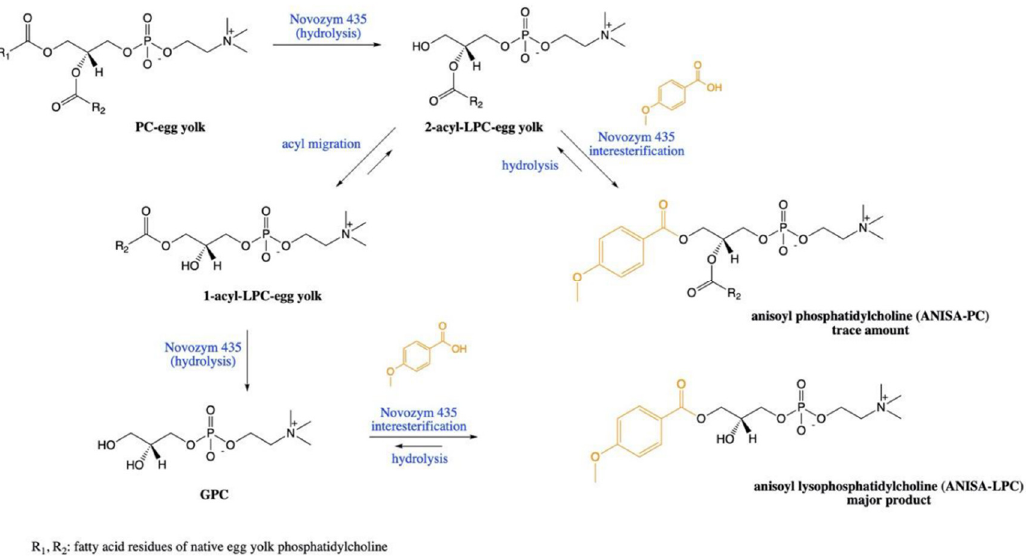
Figure 4. The possible pathway of the enzymatic synthesis of anisolylated phospholipids during the acidolysis reaction of egg−yolk phosphatidylcholine (PC) with anisic acid (ANISA) . Reprinted with permission from Ref. [25]. 2020, MDPI.